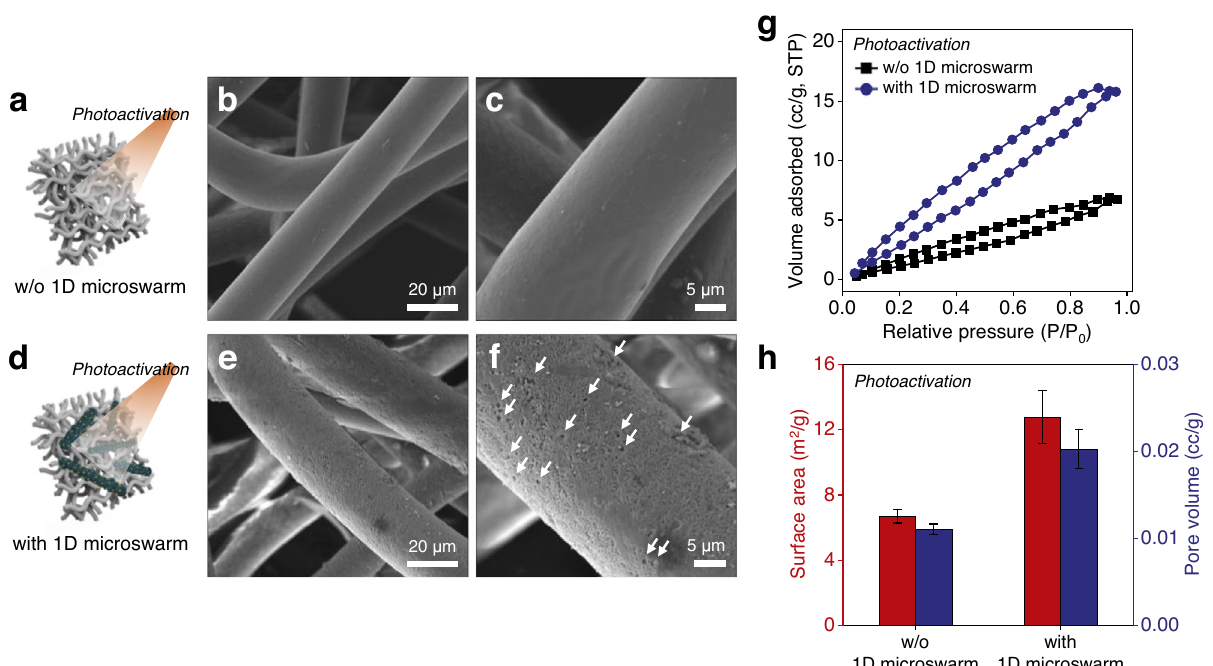
Fig.6|Morphologicalcharacterizationofthepolypropylene fi ltermembranes after photoactivation with and without 1D microswarm. a – f Schematic illus- trations and different magni fi cation SEM images of the micro fi ber network after photoactivation without ( a – c ) or with treatment of the 1D microswarm boosting ( d – f ). g , h BET surface area analysis for the quanti fi cation of morphological